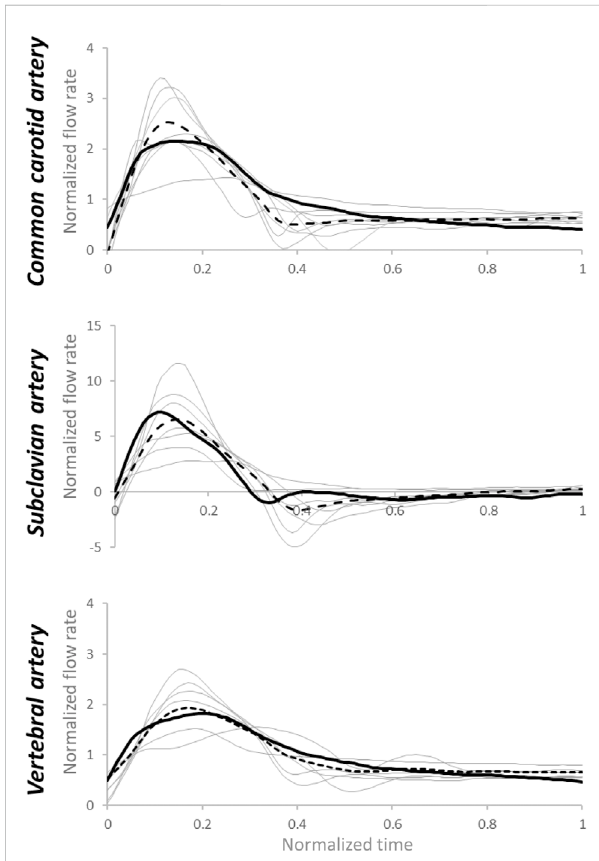
FIGURE 8 Estimated fl ow rate waveforms (grey lines) using patient- speci fi c inputs of pressure data and estimated R 1 , C, and R 2 values based on medians of arterial-speci fi c parameters. Dotted lines represent the average of estimated fl ow rates, while the black continuous line represents the average of measured fl ow rates. Normalization has been performed post-simulation for comparison purposes.